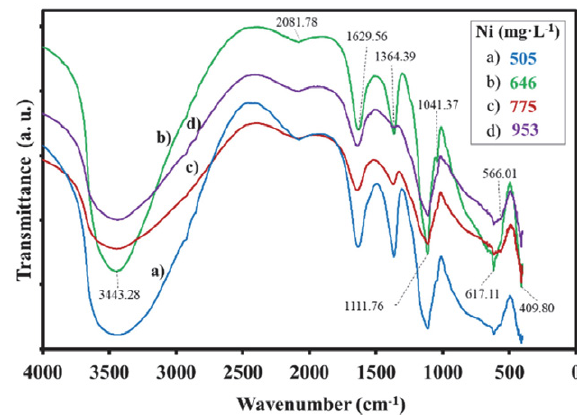
Figure 4. XRD of Ni/Al-LDH, Cu Kα1, λ=1.540598 Å, at 9.8 mA/ cm 2 , 30 min, 60 °C and pH 8.6. a) Diffraction intensity for various Bragg reflection angles. b) Interaction of the basal axis c 0 with the molar ratio M(II)/M(III). c) Crystallite volume interaction V (Å) 3 with M(II)/M(III).